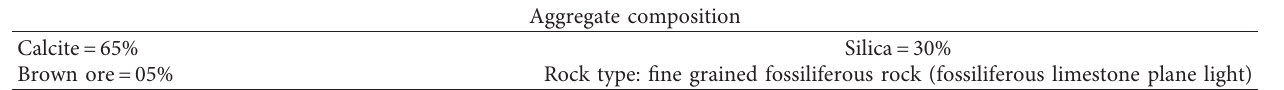
Table 5: Petrographic composition of Margalla aggregate.